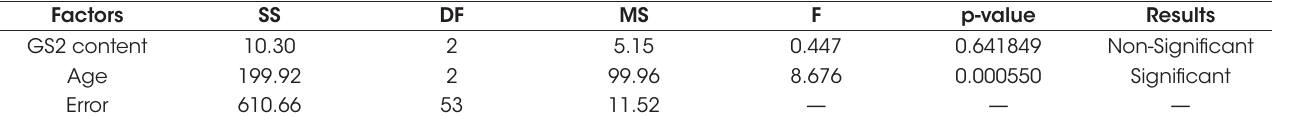
Statistical analysis of the compressive strength of concrete with GS2 Factors